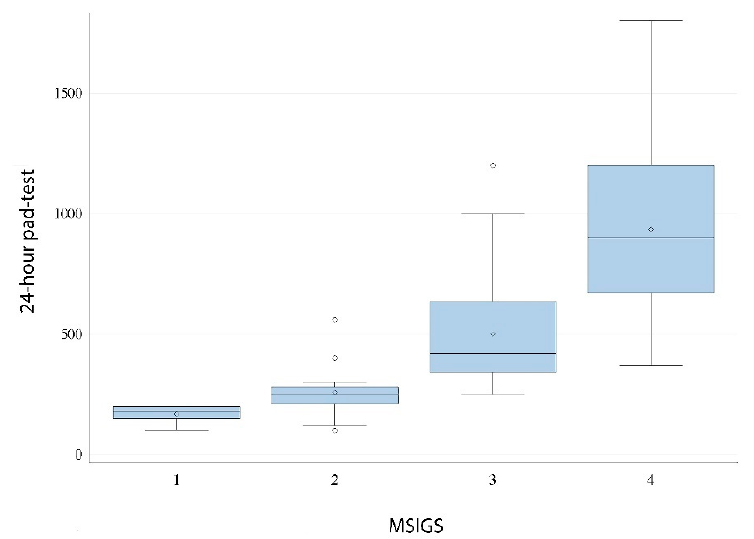
8 of 13 Figure 3. ROC curves for comparisons.